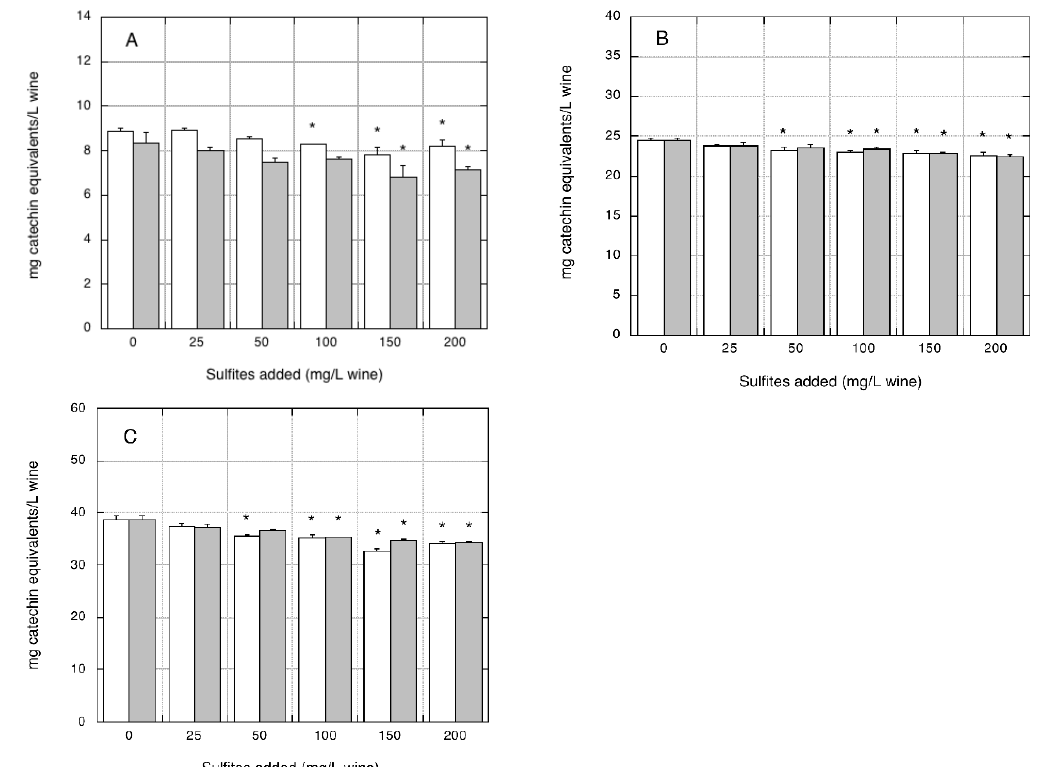
Figure 4. Effect of sulfite/metabisulfite addition to organic white wines on flavonoids measurements. Flavonoids assay was performed using catechin for the calibration curve. ( A ) AO organic wine. ( B ) BO organic wine. ( C ) CO organic wine. Closed grey bars: sodium sulfite addition. Open white bars: sodium metabisulfite addition. Data are means of four replicates ± SE. * p < 0.05 relative to control without sulfite/metabisulfite addition by Student t -test.